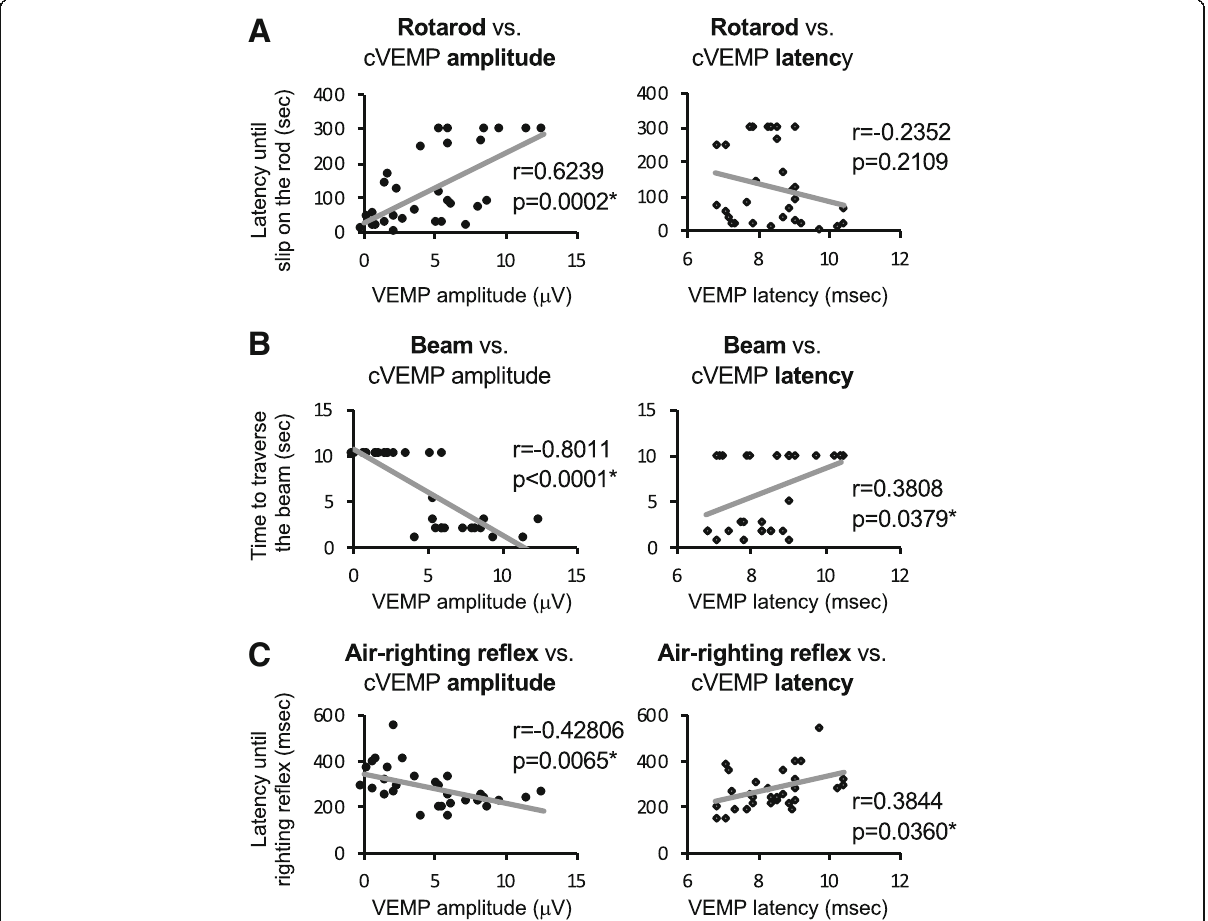
Fig. 4 Correlations between scores of the behavior tests and cVEMP results. a – c Correlations of a rotarod test score [latency until slipping on the rod, seconds (sec)], b beam crossing test score [time to traverse the beam, seconds (sec)], and c air-righting reflex test score [latency until righting reflex, milliseconds (msec)] with cVEMP amplitude [microvolts ( μ V), left graphs] and VEMP latency (msec, right graphs) are shown. Triplicated measurements for each test with a total of 10 mice including 5 mice for the control group and 5 mice for the IDPN group were performed. Spearman ’ s rank correlation coefficients and significance differences (* p <0.05) were analyzed for a rotarod vs. cVEMP amplitude [ r =0.6239, p =0.0002] and cVEMP latency [r= − 0.2352, p =0.2109], b beam vs. cVEMP amplitude [ r = − 0.8011, p <0.0001] and cVEMP latency [ r =0.3808, p =0.0379], and c air-righting reflex vs. cVEMP amplitude [ r = − 0.42806, p =0.0065] and cVEMP latency [ r =0.3844, p